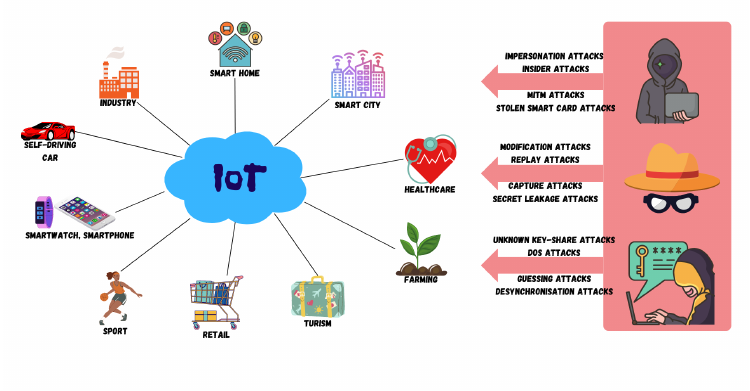
Figure 1. IoT solutions and typical cyberattacks on IoT